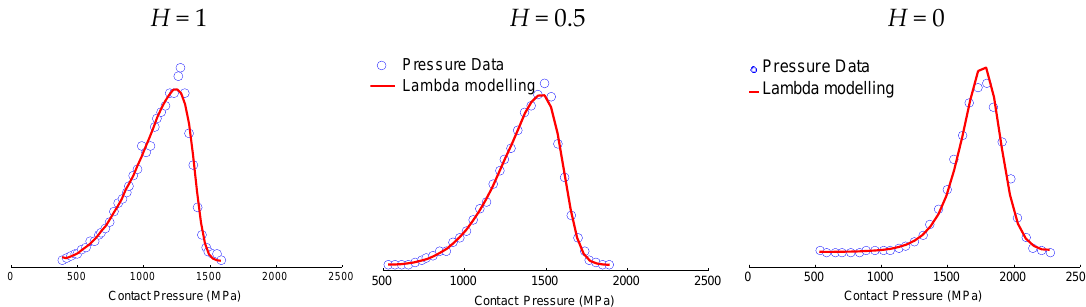
Figure 4. Plots of the GLD probability density functions and empirical histograms parameters for the three local pressures corresponding to the Hurst exponent of H = 0, 0.5 and 1.